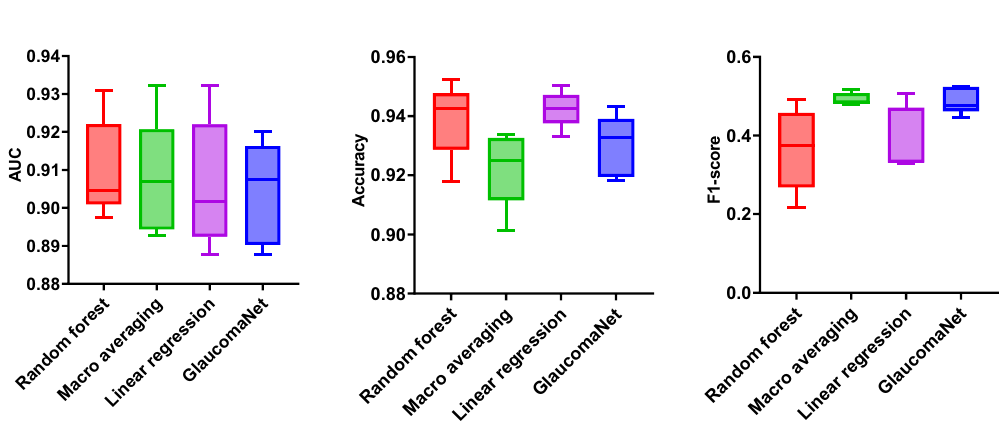
Figure 4. Comparison of different metrics (standard deviation) for different model architectures in the OHTS dataset. p-values are calculated between GlaucomaNet and other models. *p-value ≤ 0.05, **p-value ≤ 0.01.